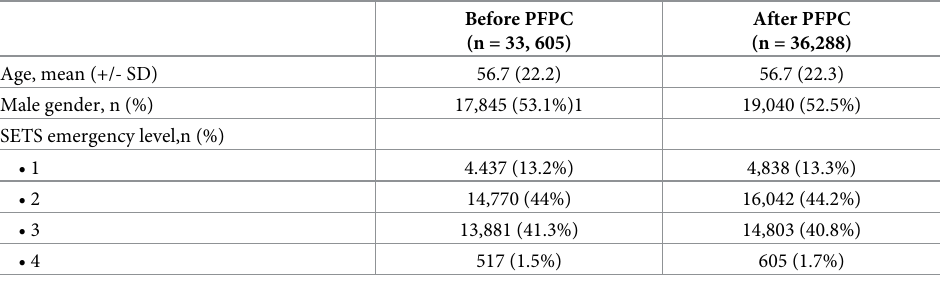
Table 1. Characteristics of patients admitted before and after introducing a patient-flow physician coordinator.